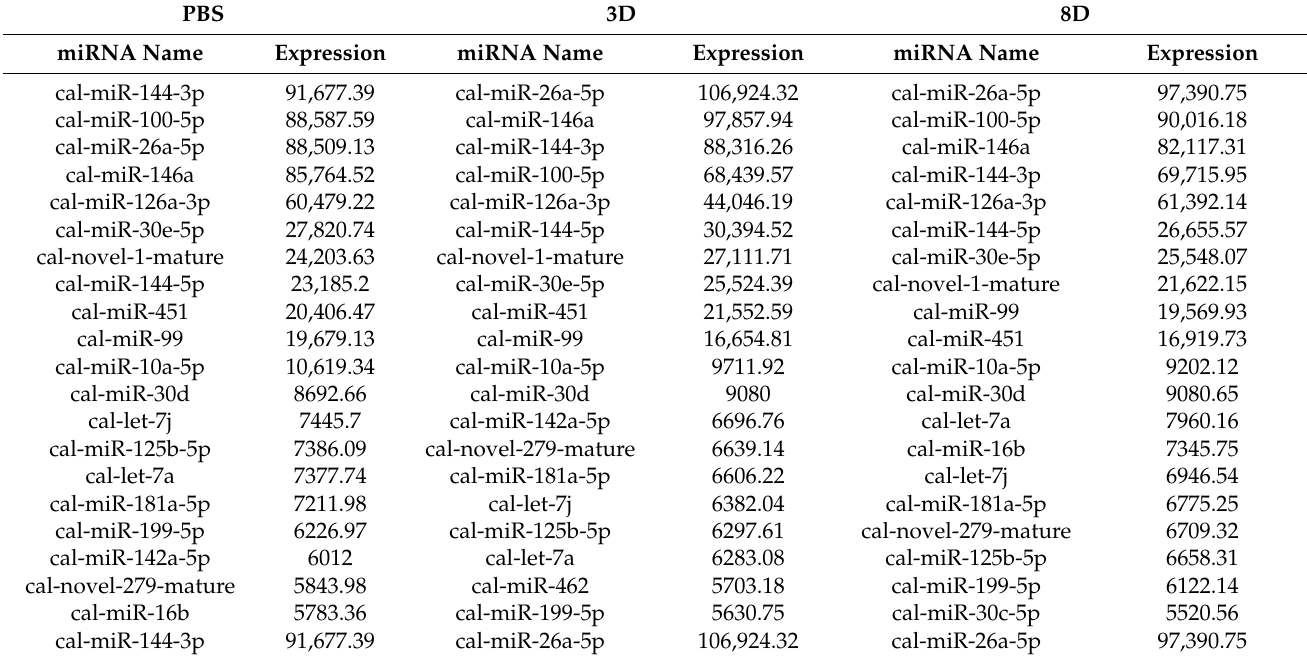
Table 1. The 20 most abundant miRNAs of the three libraries in C. altivelis following NVV challenge. Expression profiles of miRNA were estimated by CPM (count per million).